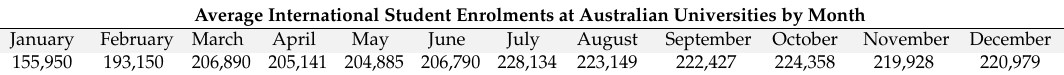
Table 1. Average International Student Enrolments at Australian Universities by Month for 2008 through